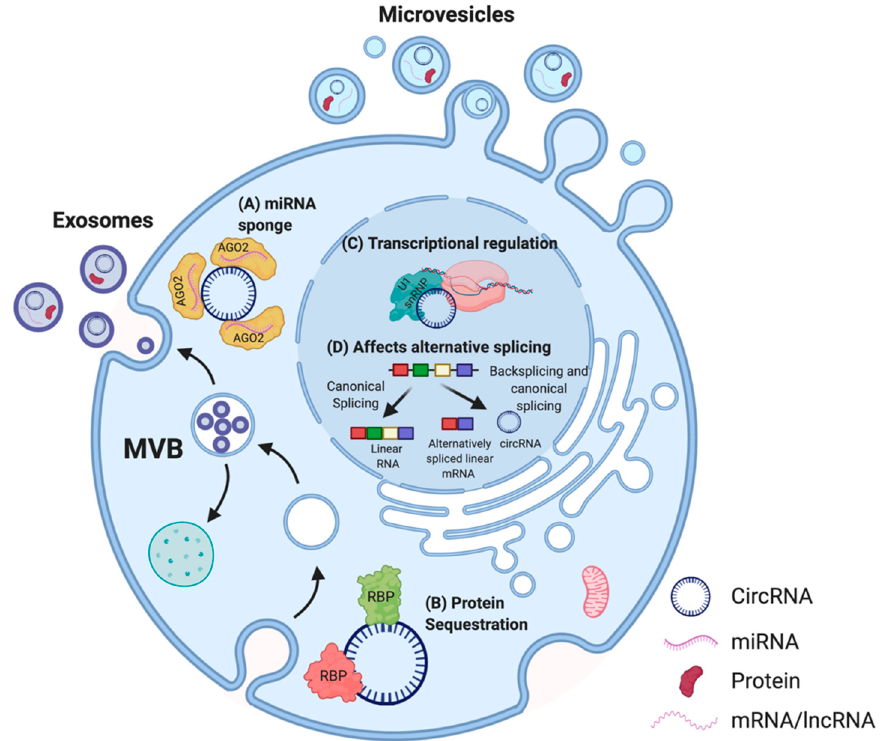
Figure 3. Proposed functions of circRNA in cells. In the cytoplasm, multiple circRNAs such as CDR1as have been shown to act as miRNA sponges ( A ) [38] whereas others possess binding sites for RBPs. For instance, circFOXO3 can act as a protein (CDK2 and p21) sequestering molecule ( B ) [39]. In the nucleus, circRNAs are able to influence the transcription of their parental genes by interacting with the U1 small nuclear ribonucleoprotein particle (U1 snRNP) and RNA polymerase II ( C ) [40] and can affect alternative splicing of transcripts, thus altering gene expression ( D ) [41]. CircRNAs can also be secreted out via extracellular vesicles (EVs) such as microvesicles or exosomes, and enable cell–cell communication [42–44]. Adapted from “Extracellular Vesicle Separation by Density Gradient Ultracentrifugation,” by BioRender.com (2020). Retrieved from https://app.biorender.com/biorender-templates .